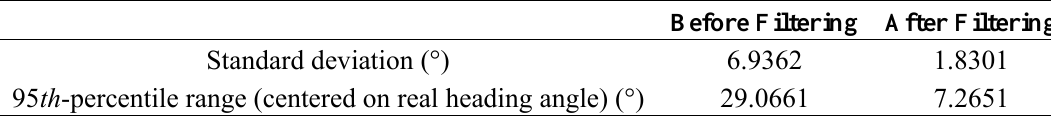
Table 2. Statistical parameters of the heading angle distributions, before and after applying the proposed Kalman filter, along a straight path with a 60° heading angle, in simulations with artificial